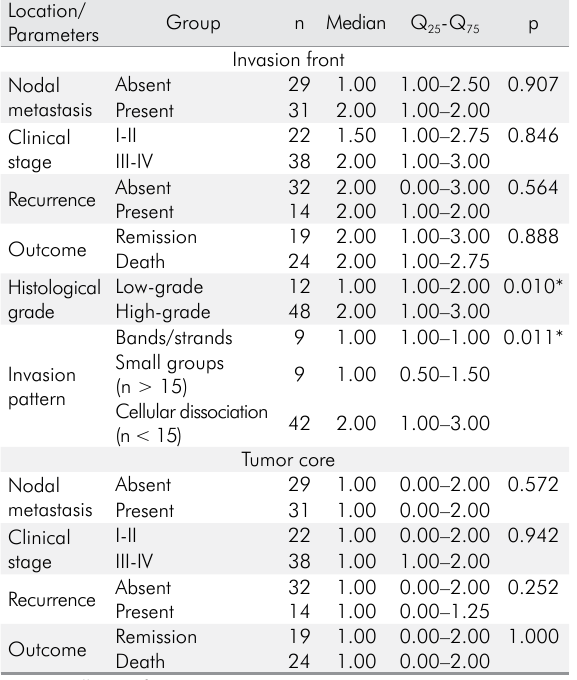
Table 2. Immunopositivity of uPA at the invasion front and in the tumor core according to clinicopathological parameters.